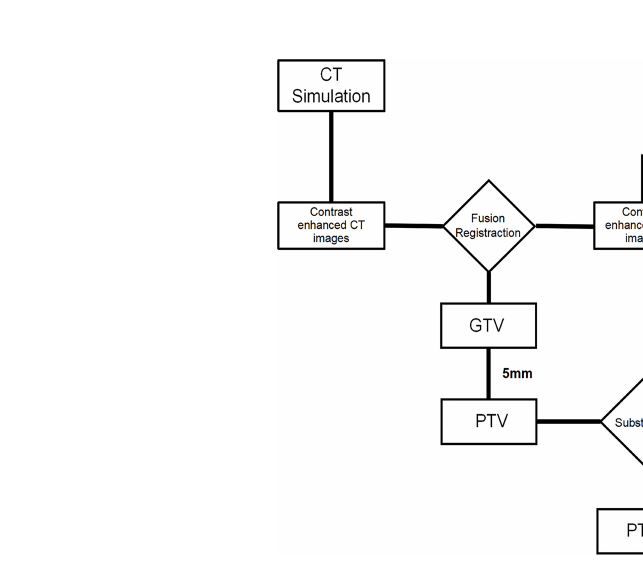
FIGURE 1 Target volume determination fl ow